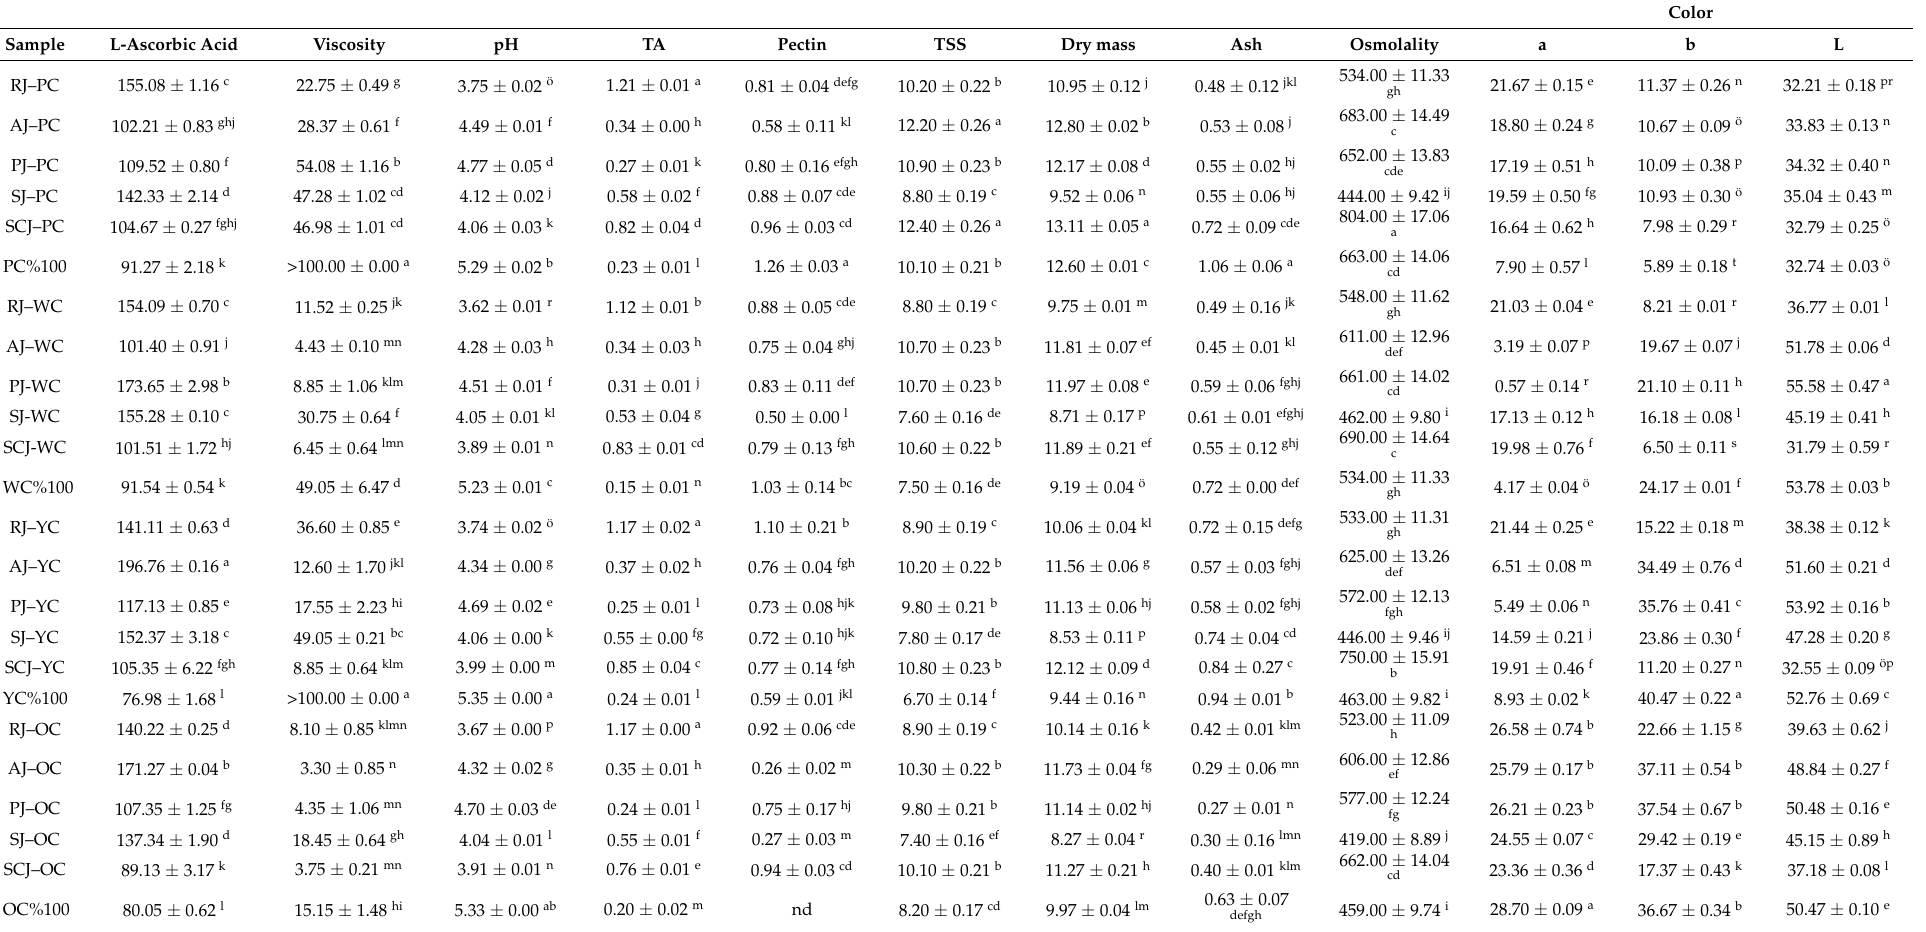
Table 1. Physicochemical parameters of carrot-blended smoothies.